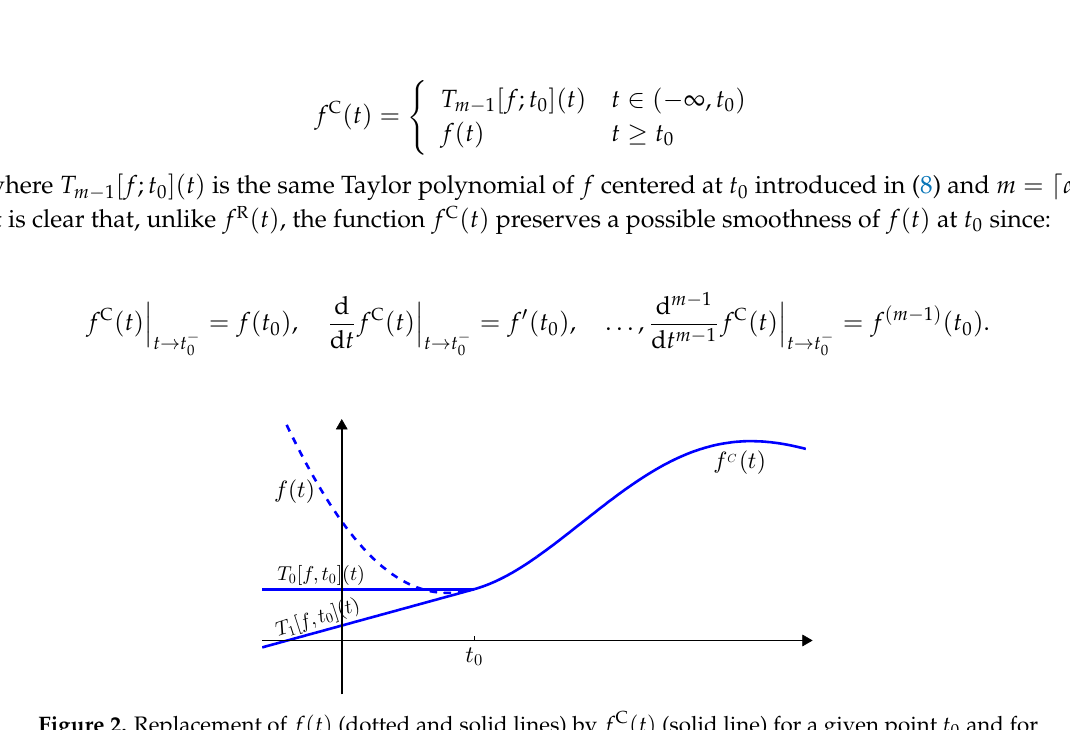
Figure 2. Replacement of f ( t ) (dotted and solid lines) by f C ( t ) (solid line) for a given point t 0 and for m = 0 (branch labeled T 0 [ f , t 0 ]( t ) ) and m = 1 (branch labeled T 1 [ f , t 0 ]( t )